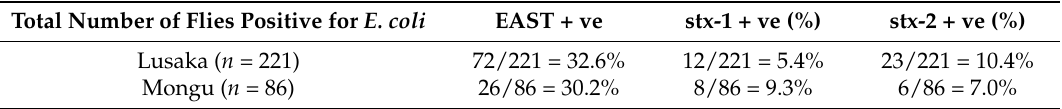
Table 1. Percentage of E. coli positive for EAST 1, stx-1 and stx-2 virulent genes for both markets. Total Number of Flies Positive for E. coli EAST + ve stx-1 + ve (%) stx-2 + ve (%) Lusaka ( n = 221) 72/221 = 32.6% 12/221 = 5.4% 23/221 = 10.4% Mongu ( n = 86) 26/86 = 30.2% 8/86 = 9.3% 6/86 =